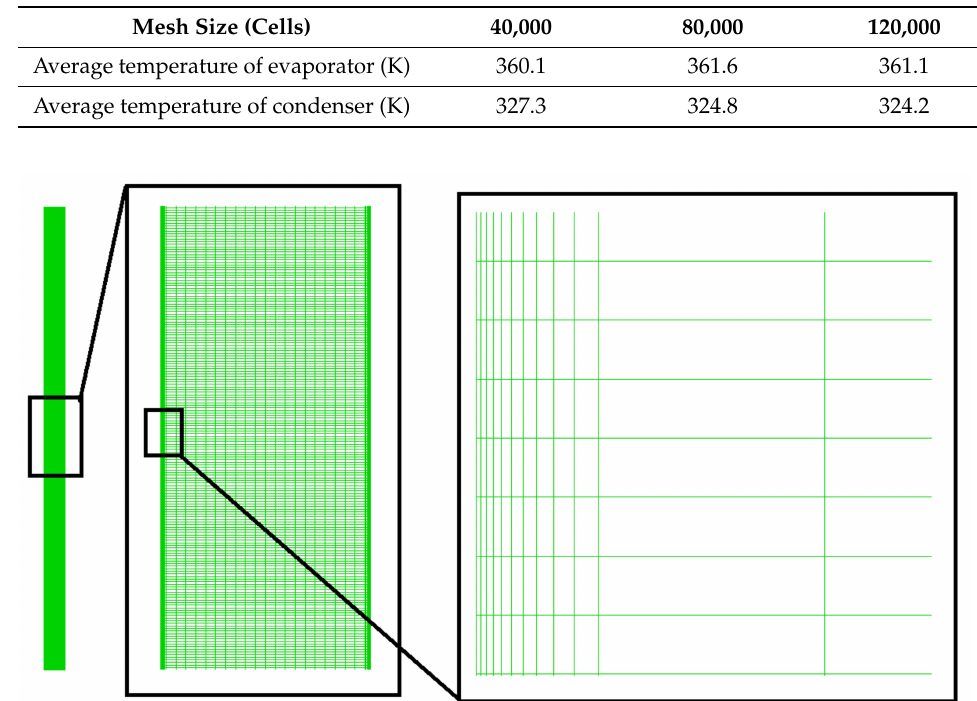
Figure 1. Mesh with 80,000 computing cells for validation.